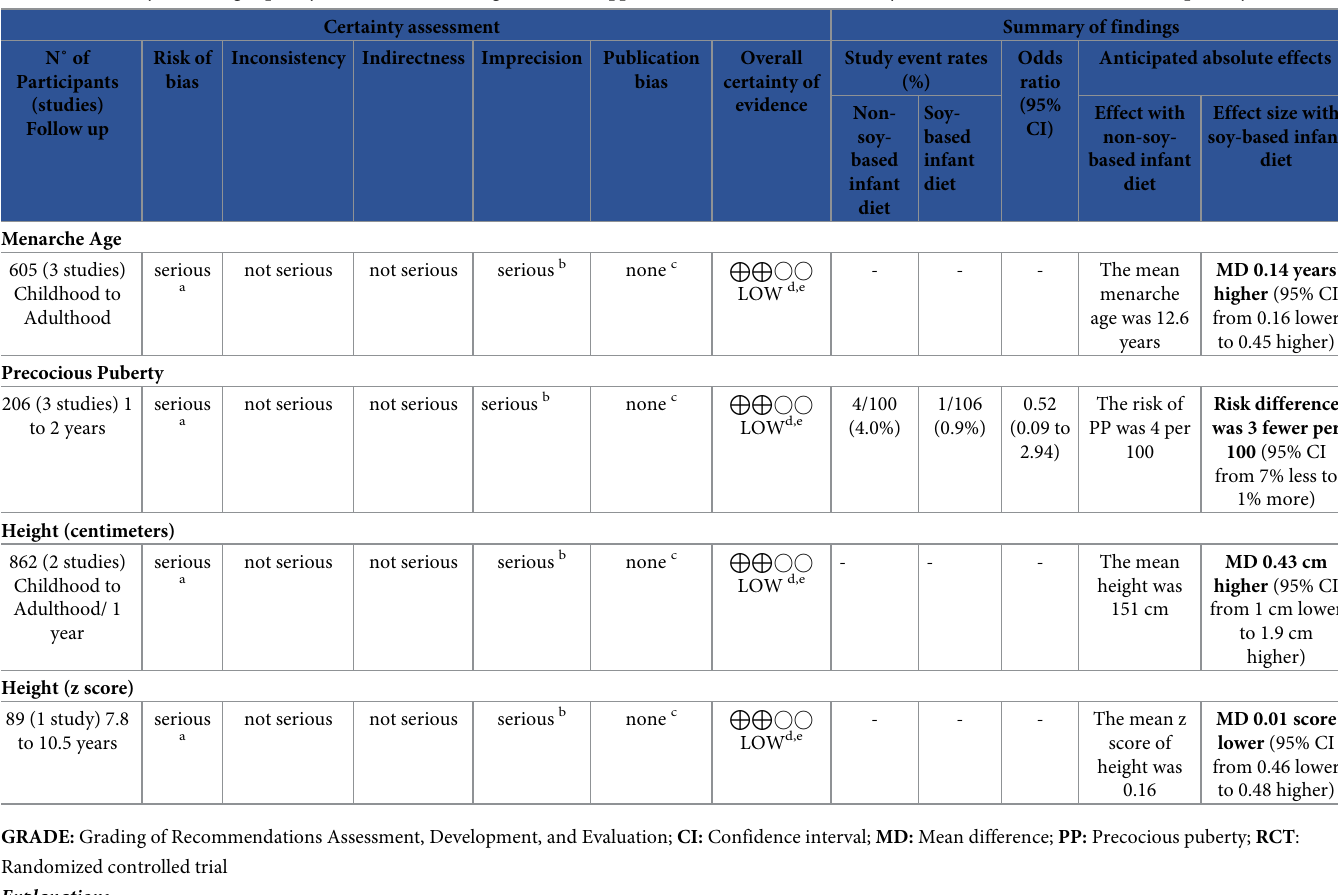
Table 4. Summary of findings–quality of evidence according to GRADE approach of association between soy-based infant diet and the onset of